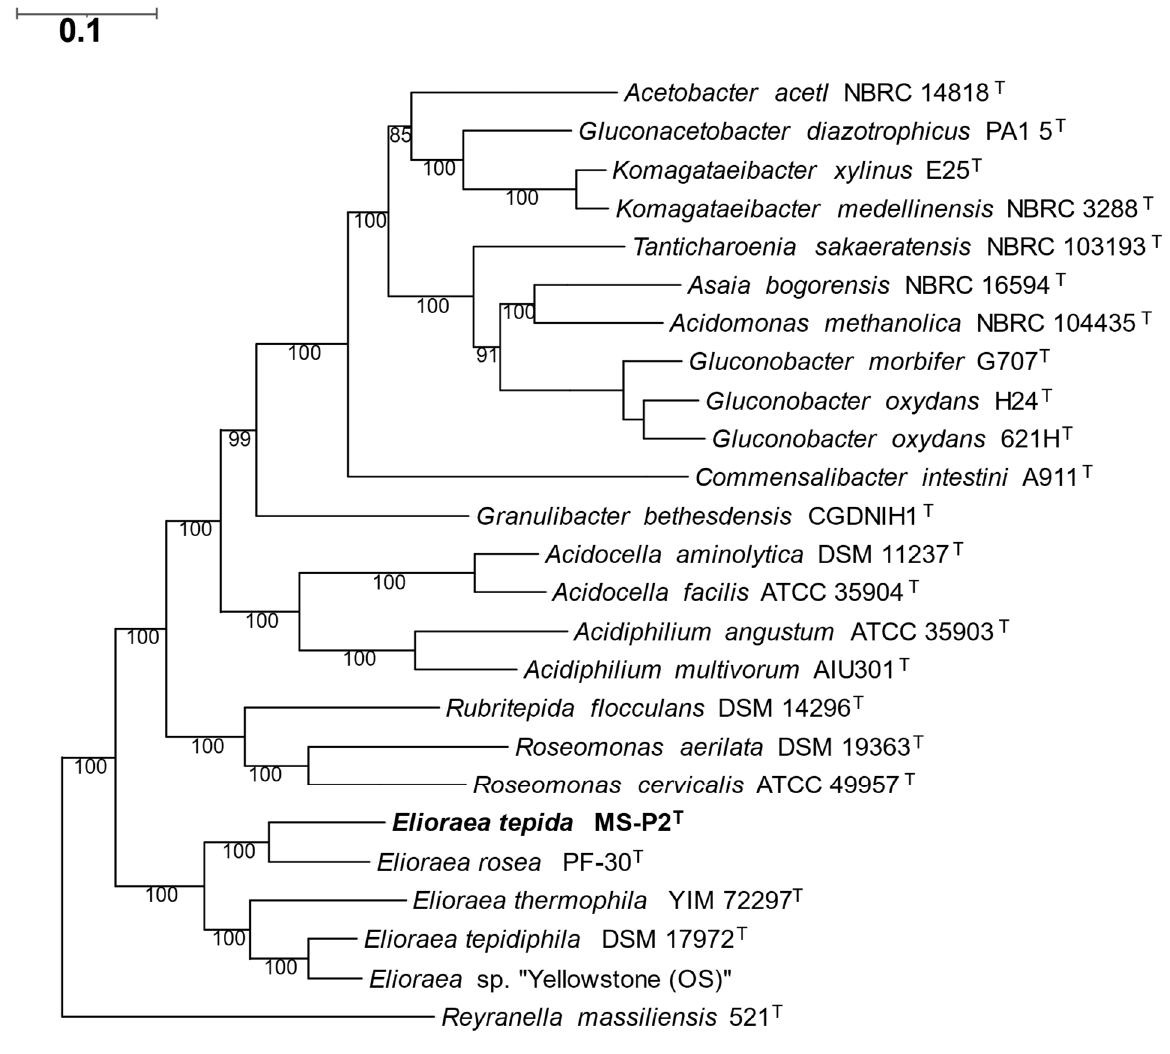
Figure 6. Inferred phylogenetic tree based on concatenated proteins using a set of 49 core universally conserved proteins/genes that shows the phylogenetic position of Elioraea tepida MS-P2 T within the genus Elioraea in comparison to selected members of the family Acetobacteraceae . The outgroup was Rayranella massiliensis , a member of the order Hyphomicrobiales . The other strains belonged to the order Rhodospirillales and the family Acetobacteraceae . The scale bar represents 0.10 substitution per site. It is interesting and surprising that strain MS-P2 T isolated from Mushroom Spring is distinctly different from Elioraea sp. “Yellowstone” isolated from nearby Octopus